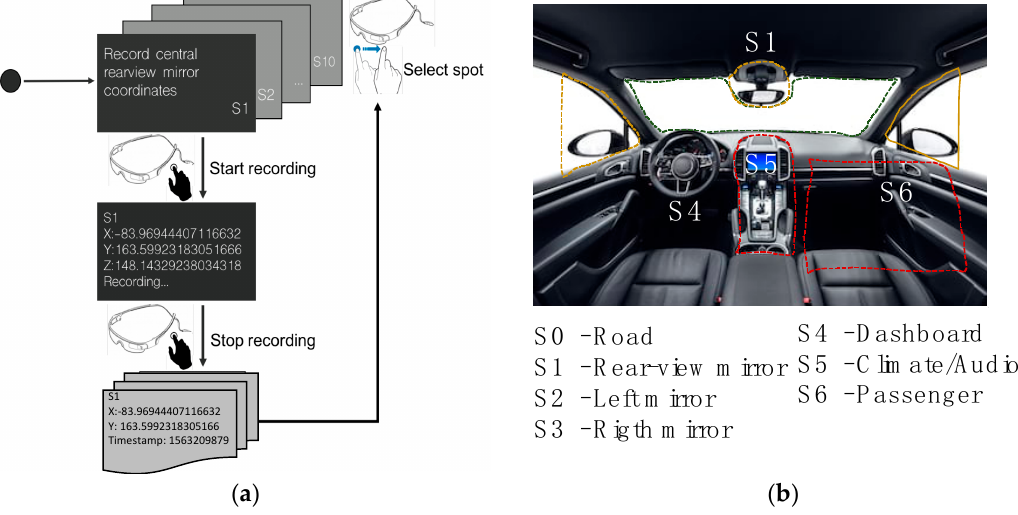
Figure 2. Drivers’ visual focus of attention (VFoA) is captured with the application presented in ( a ), which enables to label the head rotation angle (RA); ( b ) Classes used to label the